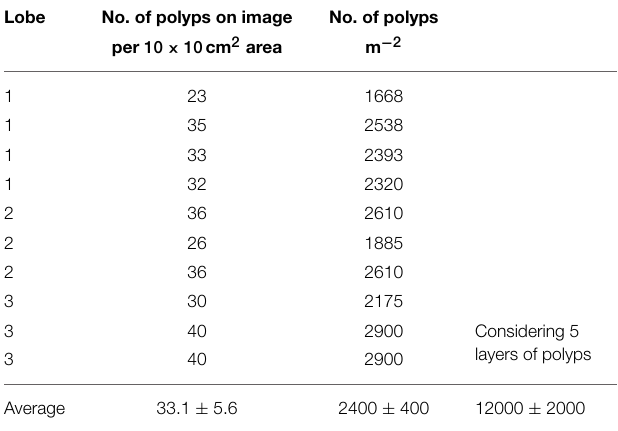
TABLE 2 | Polyp density of Reef R1 based on ROV video survey images. Lobe